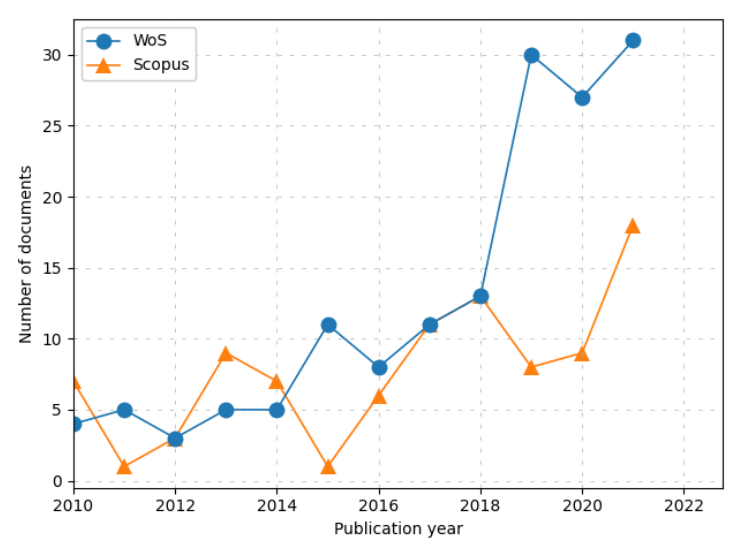
Figure 1. Annual scientific production related to keywords “Multi-objective optimization”, “Health”, and